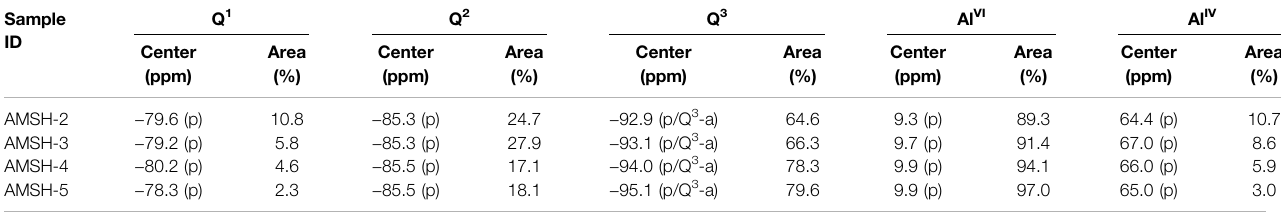
TABLE4| 29 SiNMRchemicalshifts(ppm)andrelativeintensities(%)fromde-convolutionofthe 29 Si/ 27 AlNMRspectrafortheAMSH-2 ∼ 5samplesaftercuringfor300 days. Sample ID